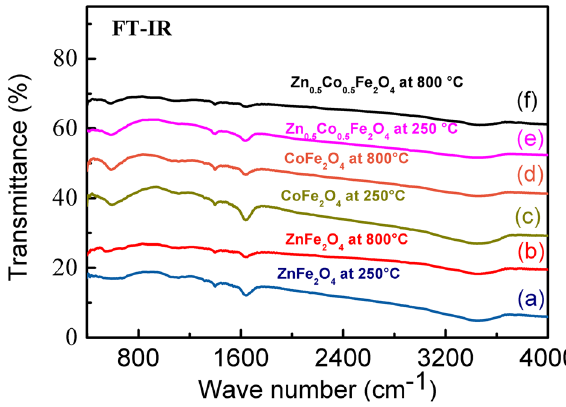
Fig. 1 Typical FTIR spectrum of calcinated nanoparticles. FTIR spectroscopy of a , b ZnFe 2 O 4 , c , d CoFe 2 O 4 , and e , f Zn 0.5 Co 0.5 Fe 2 O 4 calcined at 250 and 800 °C